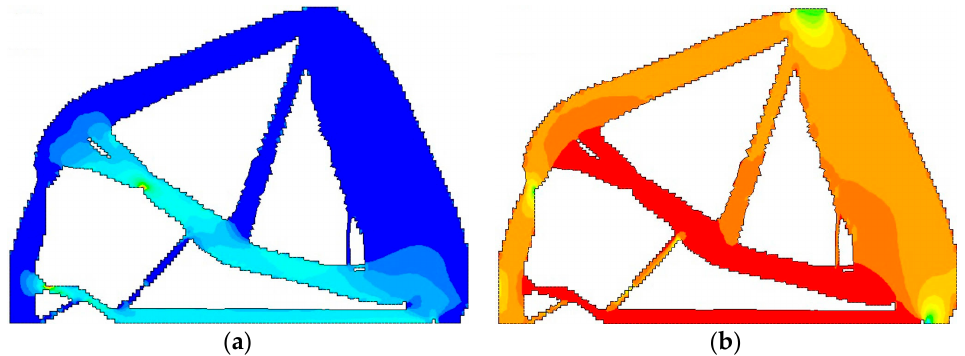
Figure 6. Stress contour plots of the Group B irregular concrete deep beams with optimal topology: ( a ) Principal tensile stress; ( b ) Principal compressive stress.